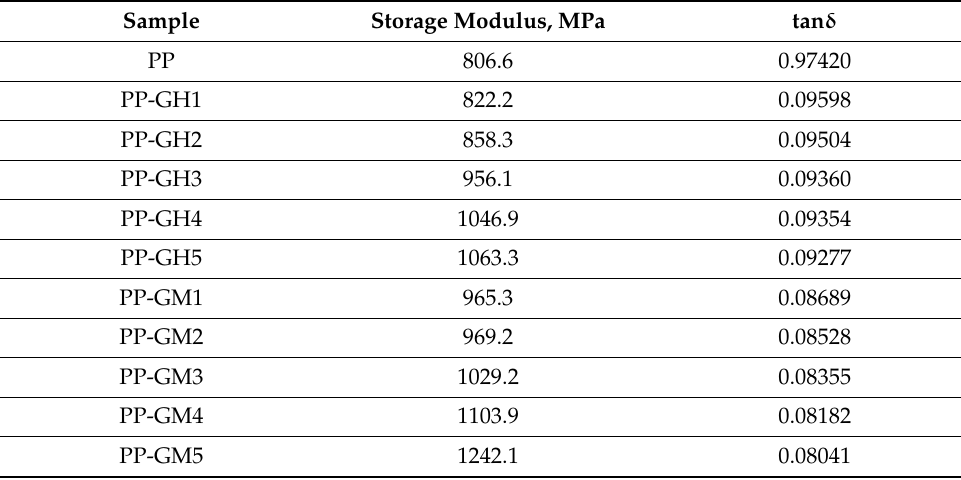
Figure 11. DMA curves of the prepared nanocomposites ( a , b ) storage modulus and ( c , d ) loss tangent. Table 6. Data pertaining to DMA properties of the nanocomposites at 60 °C.